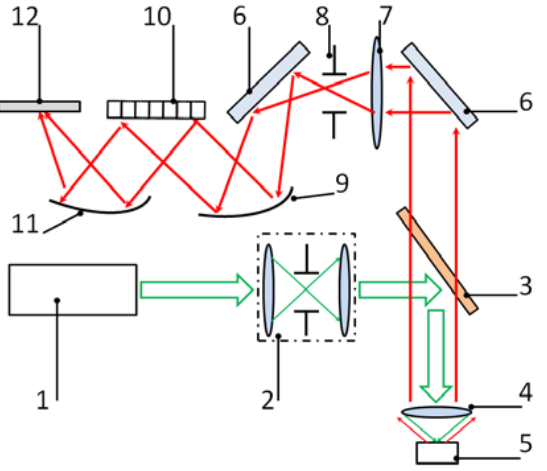
Figure 3. Design of the Raman spectroscopy setup: 1—laser source; 2—spatial filter; 3—edge-filter; 4—lens; 5—sample; 6—mirror; 7—condenser; 8—entrance slit of the spectrometer; 9, 11—aspherical mirrors; 10—diffraction grating; 12—CCD camera.